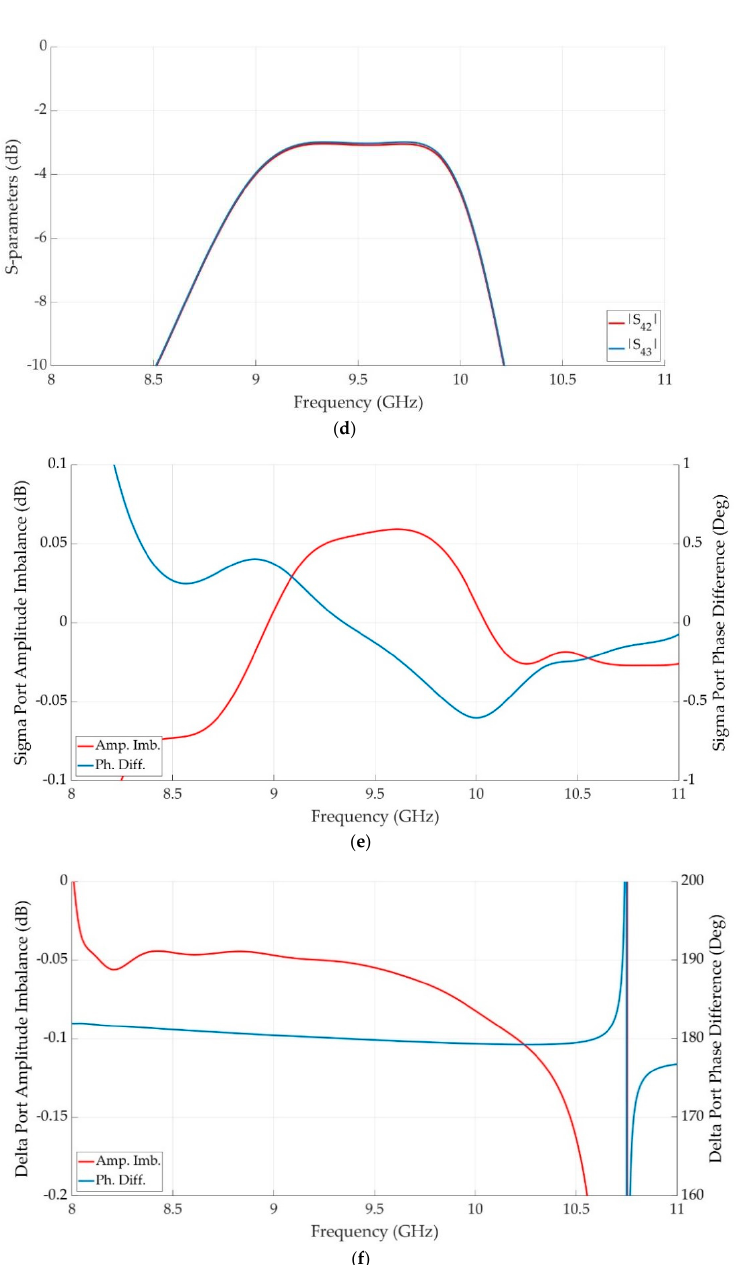
Figure 10. TMT simulated scattering parameters. ( a ) Port matching. ( b ) Port isolation. ( c ) Transmission coefficients (sum port excited). ( d ) Transmission coefficients (difference port excited). ( e ) Amplitude imbalance and phase difference (sum port excited). ( f ) Amplitude imbalance and phase difference (difference port excited).